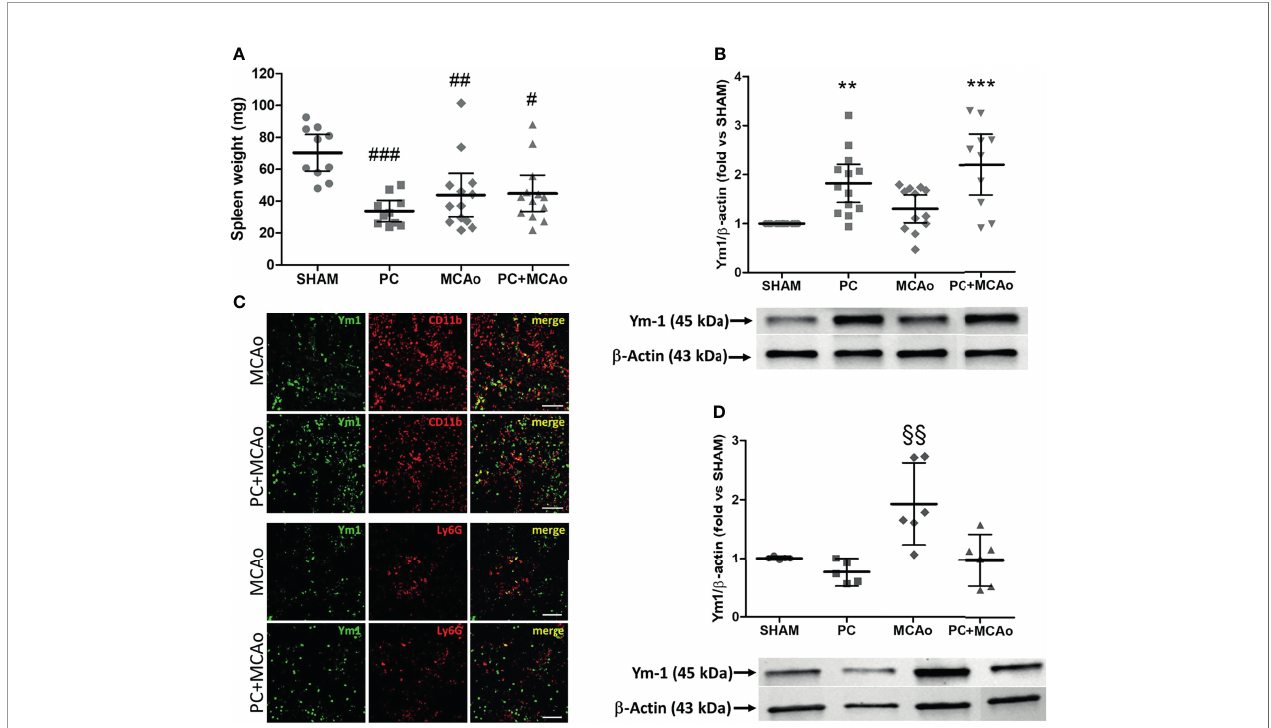
FIGURE 2 | Ischemic PC does not affect spleen contraction induced by MCAo, while it elevates expression of the M2 marker Ym1 in spleen but not in circulating leukocytes. (A) Spleen weight and protein expression levels of Ym1 in spleen (B) and in circulating leukocytes (D) of mice subjected to SHAM surgery, ischemic PC (15 min MCAo followed by 72h of reperfusion), 1h MCAo followed by 24h of reperfusion (MCAo) or PC+MCAo. (C) Representative immuno fl uorescence images showing Ym1 expression (green fl uorescence) in CD11b immunopositive myeloid cells and Ly-6G immunopositive neutrophils (red fl uorescence) in the spleen parenchyma of mice undergone 1h MCAo preceded (72h before) by sham surgery (MCAo) or by ischemic PC (PC+MCAo). Scale bars = 50 m m. Data were analysed by one-way ANOVA followed by Tukey ’ s post-hoc test [ (A) # P = 0.0083, ## P = 0.0057 and ### P = 0.0002 vs SHAM, n = 10-13 mice per experimental group; (B) **P = 0.0046 vs SHAM, ***P = 0.0001 vs SHAM and P = 0.0037 vs MCAo, n = 8-13 mice per experimental group; (D) §§ P = 0.0098 vs SHAM, P = 0.0013 vs PC and P = 0.0051 vs PC+MCAo, n = 5-6 mice per experimental